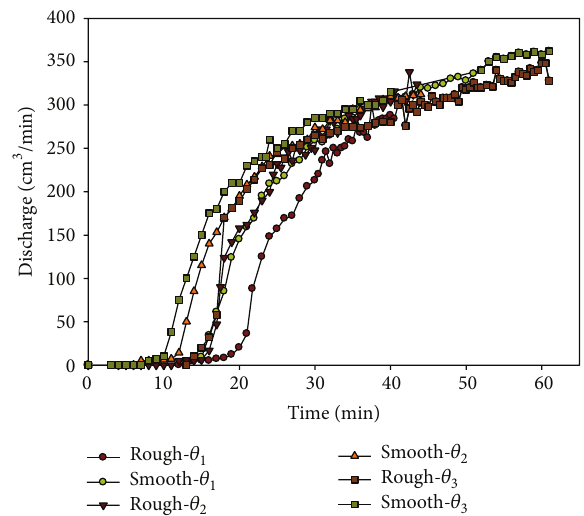
Figure 4: Observed hydrographs of the laboratory rough and smooth surfaces for three soil moisture conditions ( 𝜃 1 = 0.120 ; = 0.165 ; and 𝜃 = 0.207 𝜃 2 3